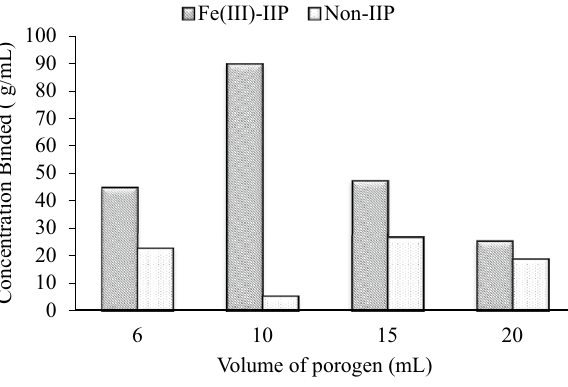
Fig. 5 Optimization of volume for the preparation of ion imprinting polymer of Fe